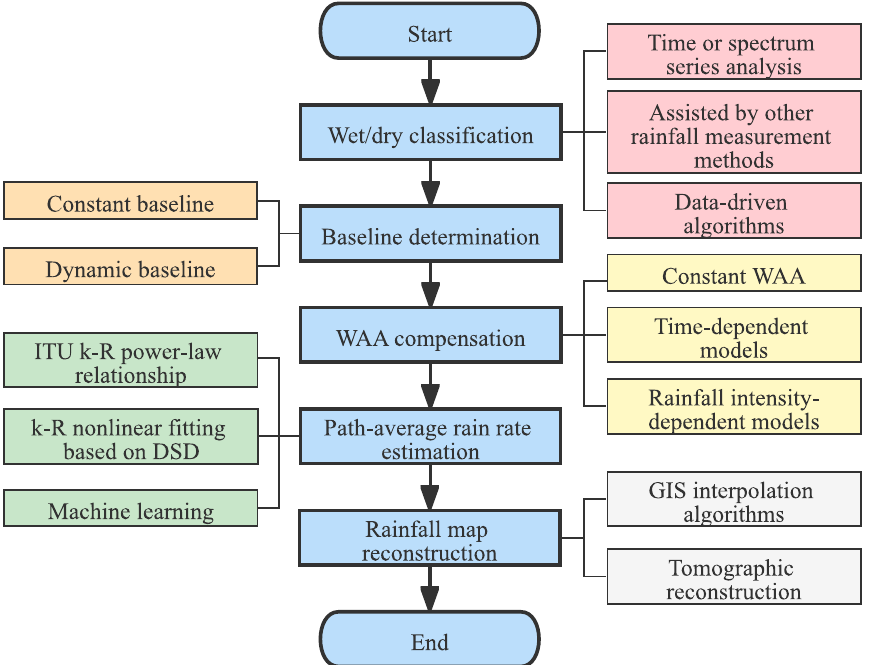
Figure 3. Typical steps in CML-based rainfall